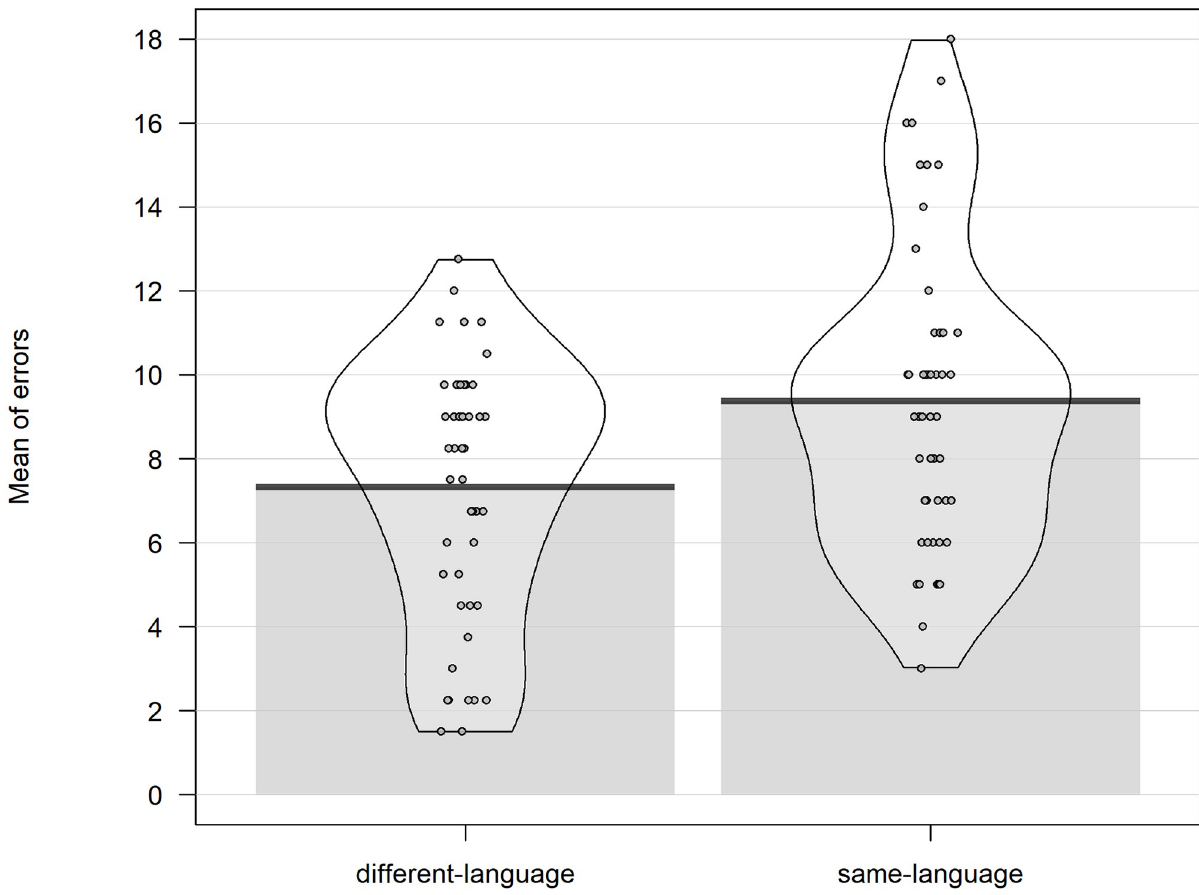
Fig 2. Language categorization. Mean of errors split by type of error for